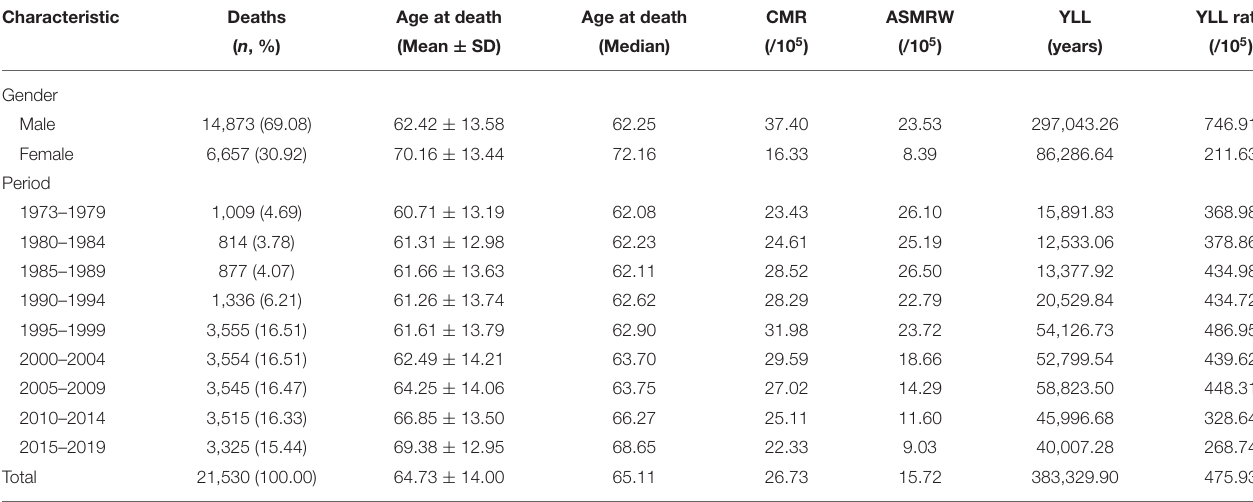
TABLE 1 | Baseline characteristics of deaths and burden in different genders and periods of liver cancer during 1973–2019. Characteristic